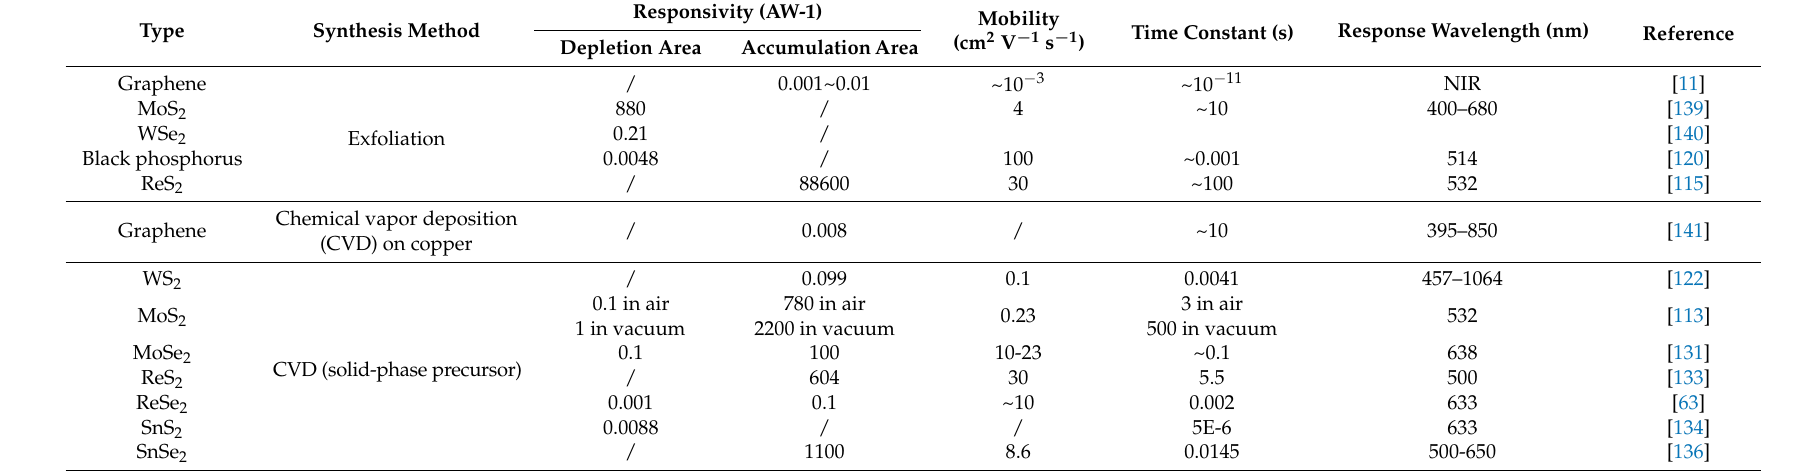
Table 1. Performance of single-channel 2D